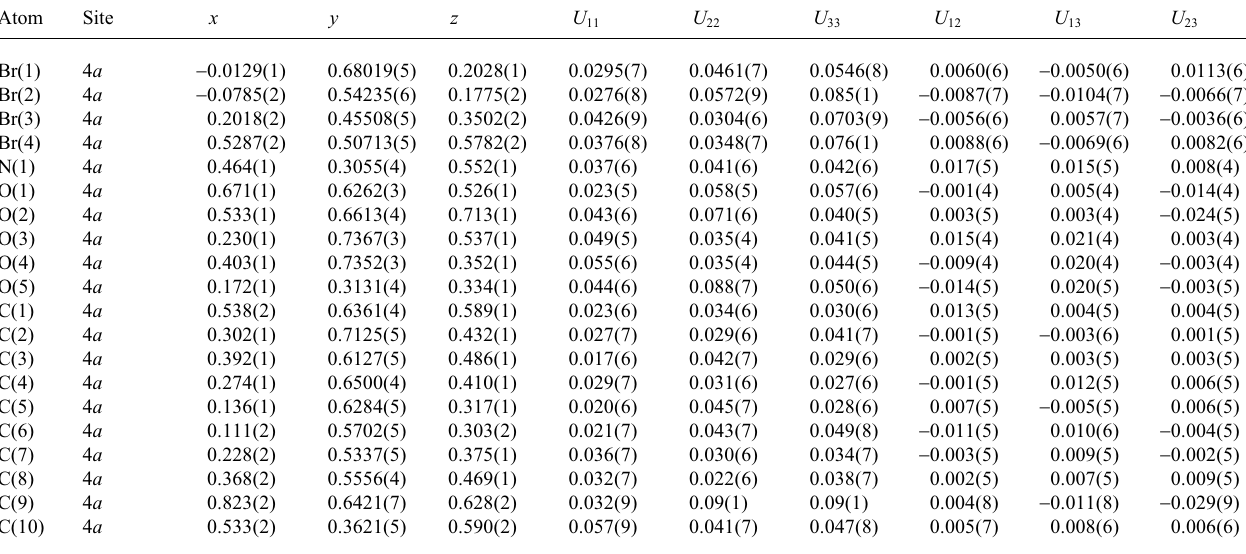
Table 3. Atomic coordinates and displacement parameters (in Å 2 )